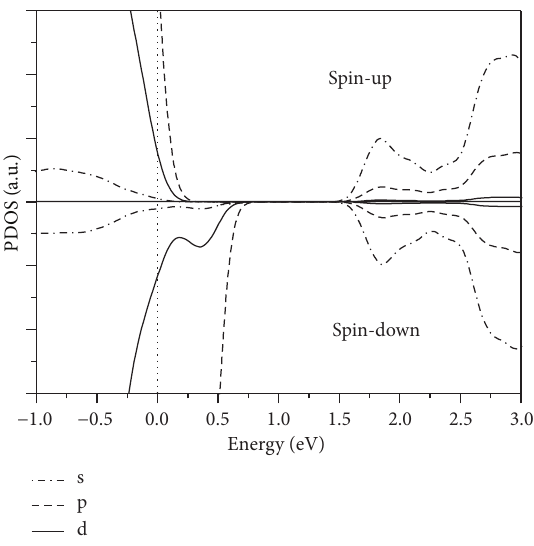
Figure 7: Calculated PDOS for ZnO nanorod with V Zn